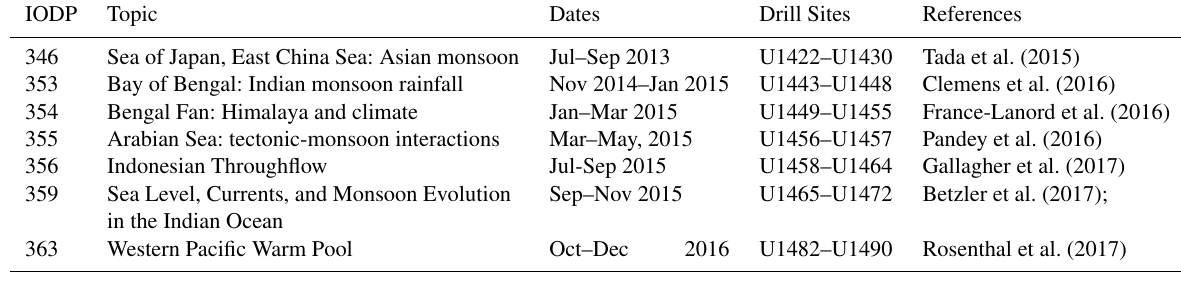
Table 1. IODP monsoon expeditions.